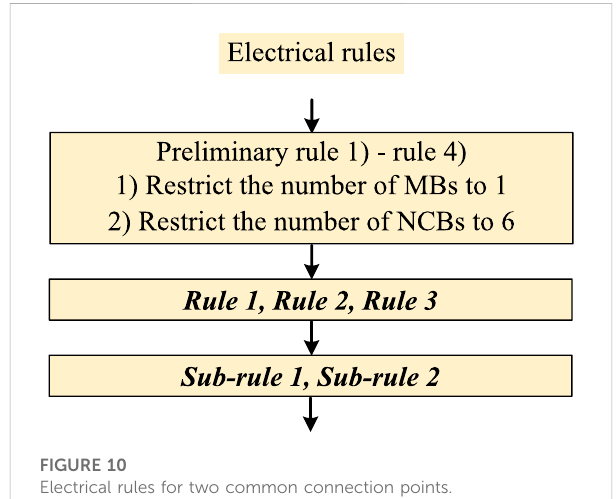
FIGURE 10 Electrical rules for two common connection